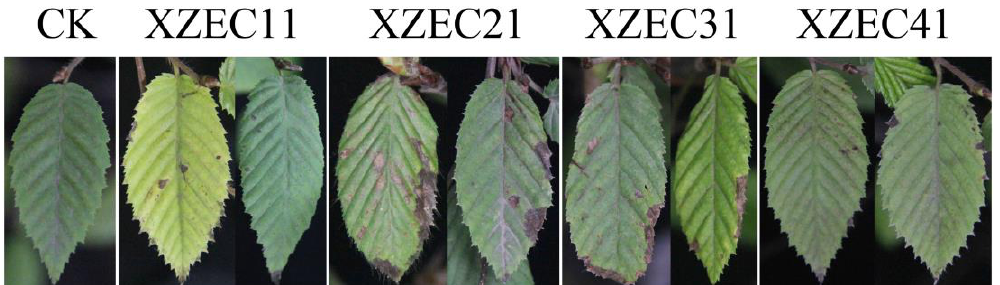
Figure 6. Symptoms on European hornbeam leaves 10 days after inoculation with spore suspensions (10 6 conidia/mL) of XZEC11, XZEC21, XZEC31, and XZEC41.